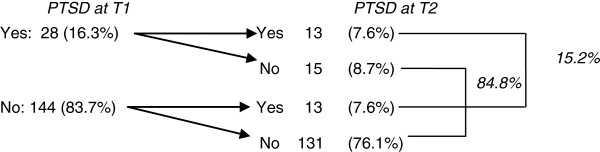
Number of respondents who scored above the PTSD cut-off point at T1 and T2.